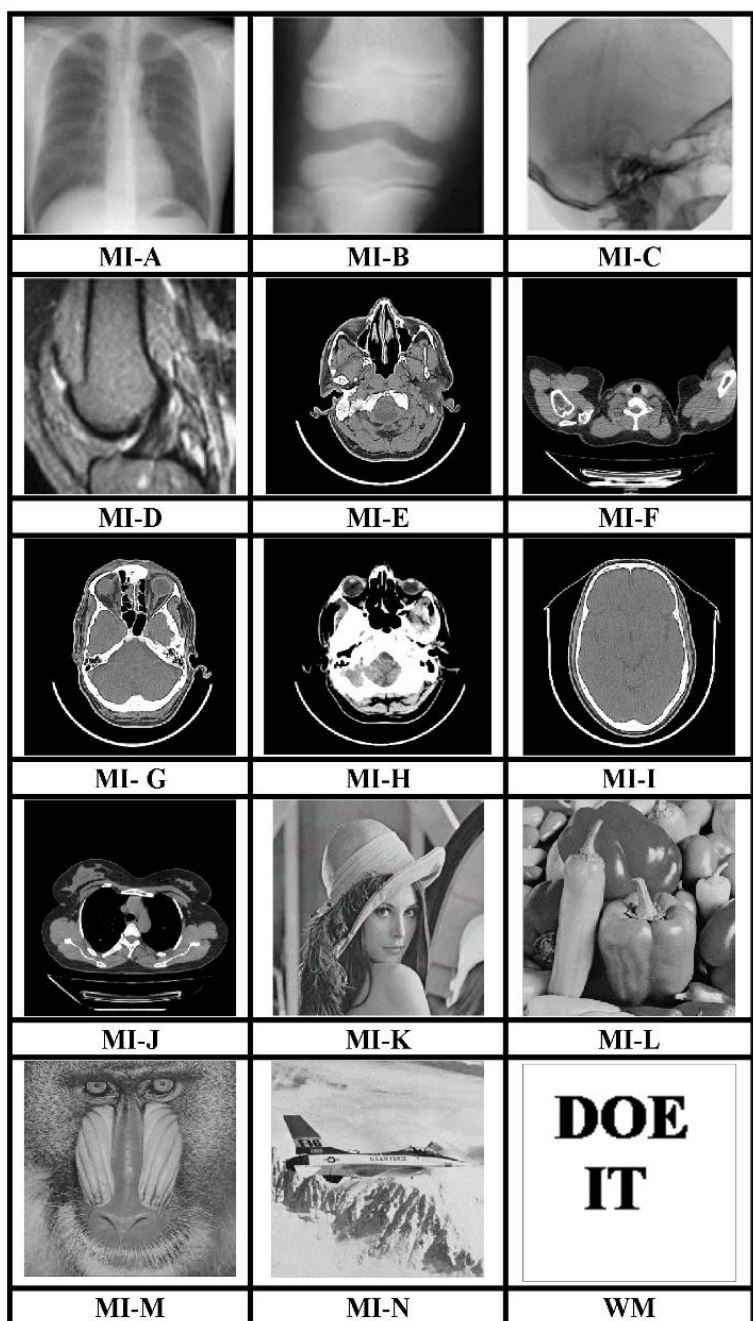
Figure 3. 512 × 512 test images and 128 × 128 binary WM.